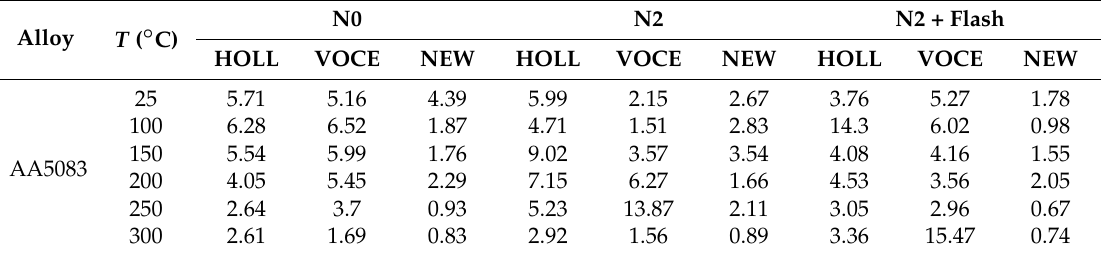
Table 12. RMSE of each flow rule obtained for AA5083 in relation to the experimental curve (MPa).